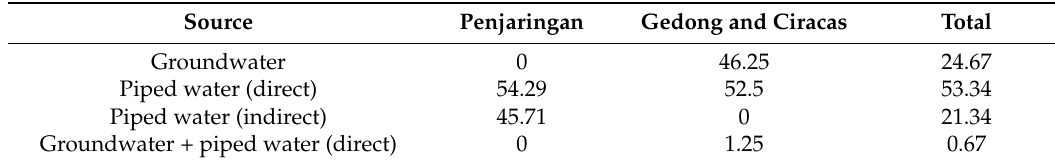
Table 4. Combinations of water sources from PDW-consuming households (percentages, Survey A). (Source: